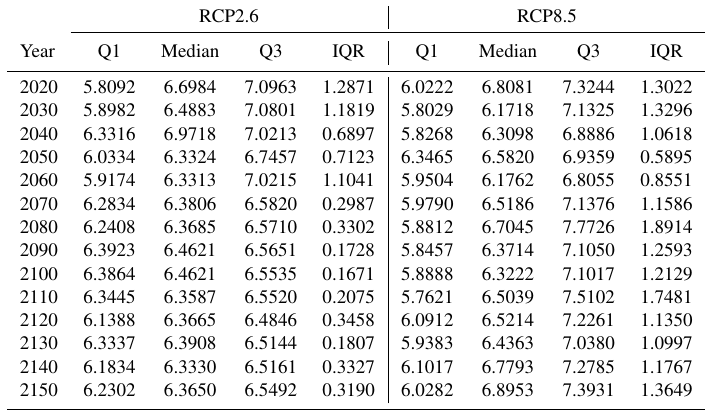
Table A3. Quartile descriptions of the distributions of the maximum equilibrium climate sensitivity (ECS) split value from each decision tree in the fitted forests. Q1 denotes quartile 1, which is the 25th percentile of the data. The median is the 50th percentile of the data. Q3 denotes quartile 3, which is the 75th percentile of the data. IQR stands for the interquartile range, which is calculated as Q3 − Q1. RCP2.6